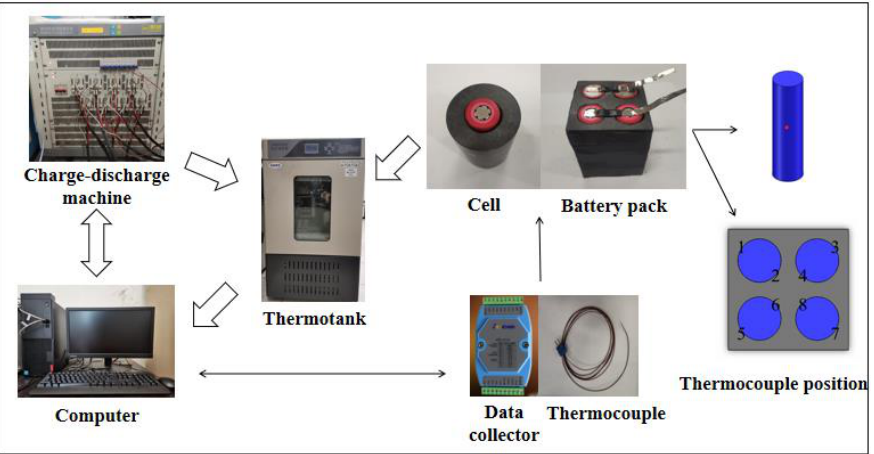
Figure 2. Thermal management system platform.